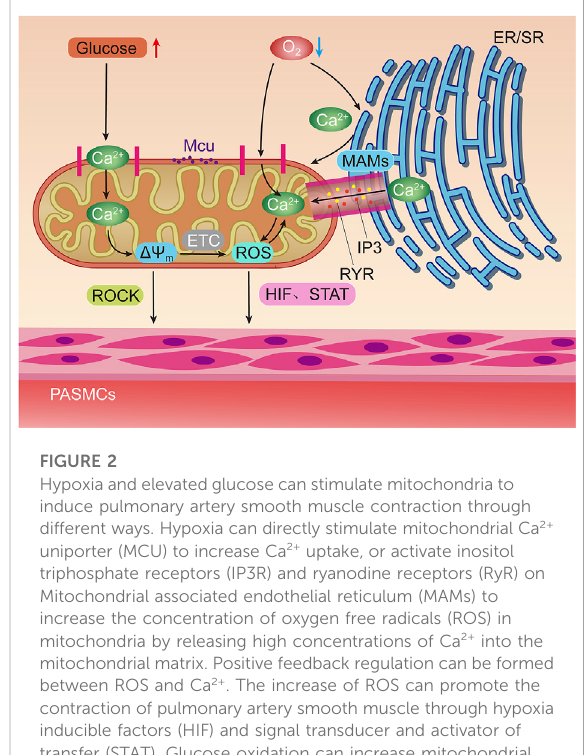
FIGURE 2 Hypoxia and elevated glucose can stimulate mitochondria to induce pulmonary artery smooth muscle contraction through different ways. Hypoxia can directly stimulate mitochondrial Ca 2+ uniporter (MCU) to increase Ca 2+ uptake, or activate inositol triphosphate receptors (IP3R) and ryanodine receptors (RyR) on Mitochondrial associated endothelial reticulum (MAMs) to increase the concentration of oxygen free radicals (ROS) in mitochondria by releasing high concentrations of Ca 2+ into the mitochondrial matrix. Positive feedback regulation can be formed between ROS and Ca 2+ . The increase of ROS can promote the contraction of pulmonary artery smooth muscle through hypoxia inducible factors (HIF) and signal transducer and activator of transfer (STAT). Glucose oxidation can increase mitochondrial membrane potential ( △ Ψ m) Concentration, thereby activating Rho/Rho kinase signal and other mechanisms to induce pulmonary artery smooth muscle